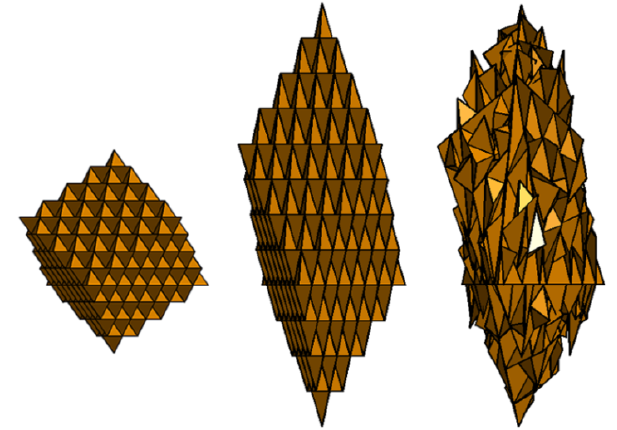
Figure 2. Third-generation Koch-fractal particles with different ge- ometric parameters. The aspect ratios of the particles from left to right are 1.0, 2.5, and 2.5, and the irregular ratios are 0, 0, and 0.3,